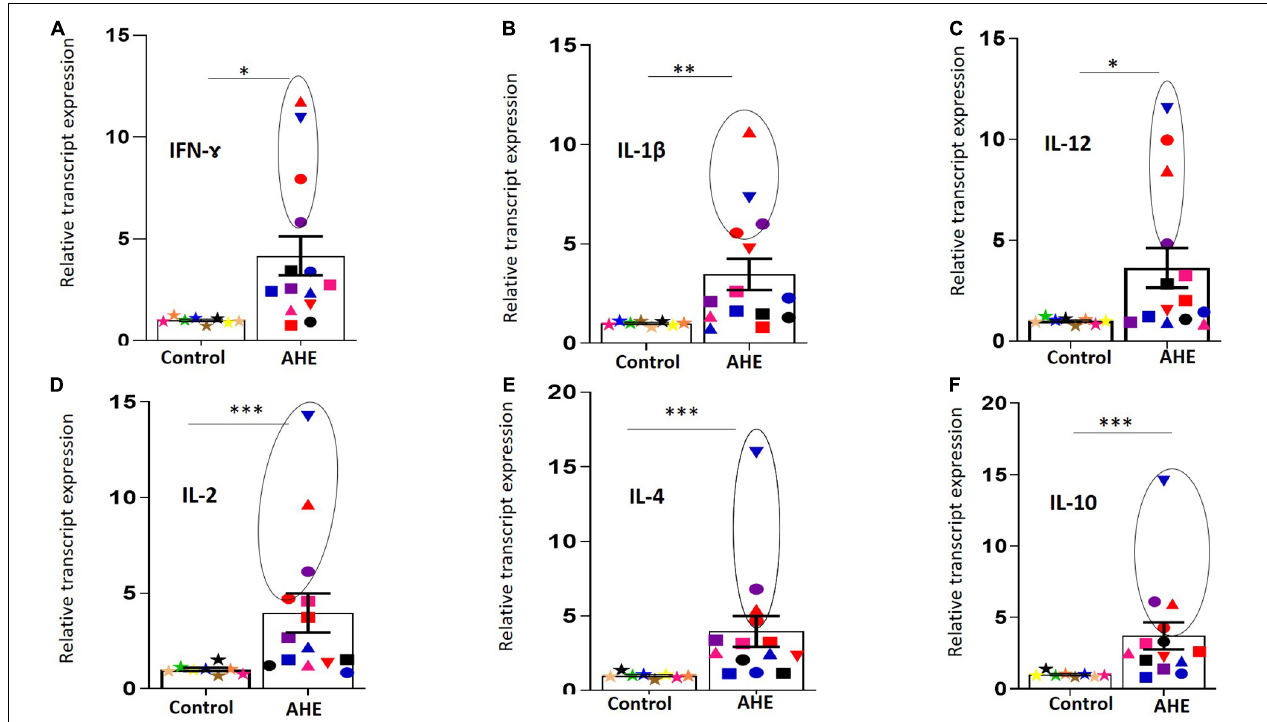
FIGURE 2 | Upregulation of the immune transcripts in the PBMCs of AHE patients. (A–F) PBMCs from AHE patients ( n = 14) and healthy controls ( n = 8) were assessed for the immune transcripts; IFN- G (A) , IL-1 β (B) , IL-12 (C) , IL-2 (D) , IL4 (E) , and IL-10 (F) by RT-qPCR. The transcript expression for each gene was normalized to the housekeeping gene. Different colors and symbols indicate different patients. Data represented as mean ± SEM. Circle is added around the PBMCs with detectable ( + ) and (–) RNA strands. *, **, *** indicate that p < 0.05, 0.01, and 0.001, respectively, as determined by Mann–Whitney